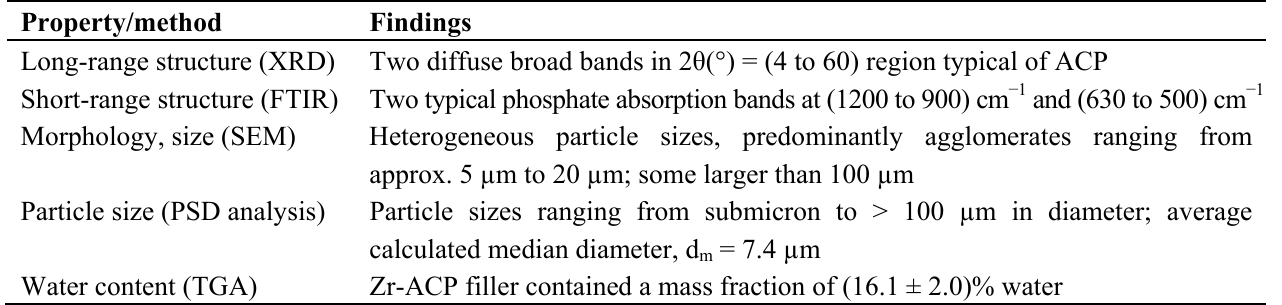
Table 1. Physicochemical properties of Zr-ACP filler used in the